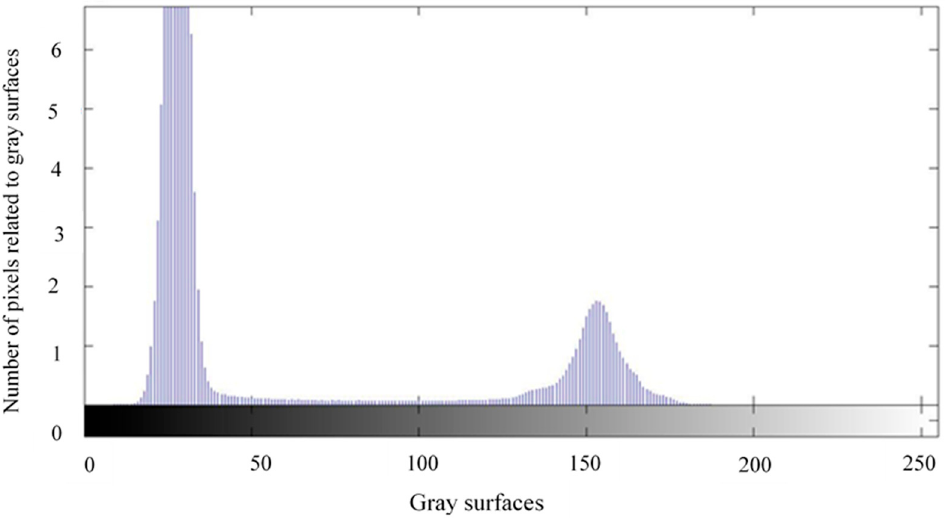
Figure 2. An example of an intensity histogram obtained by images.